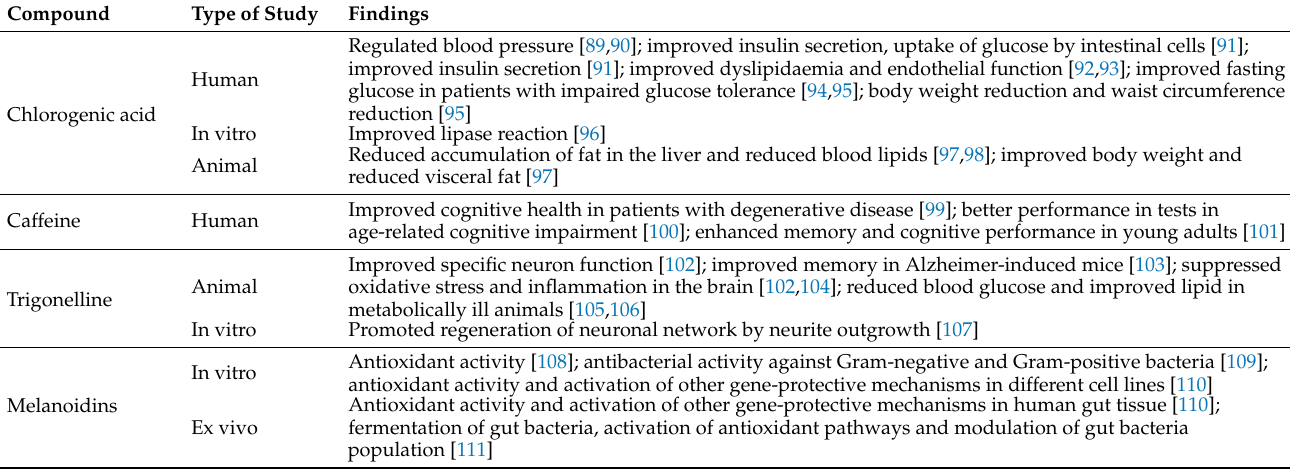
Table 1. Studies analysing the components of spent coffee grounds and their